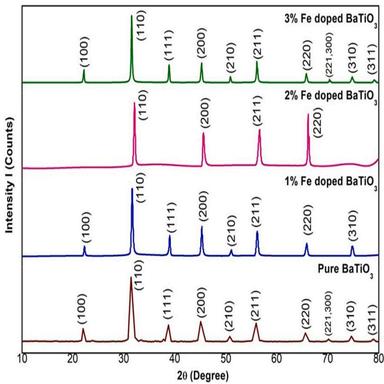
XRD pattern of pure and Fe doped Barium Titante (BaTiO3) nanoparticles.